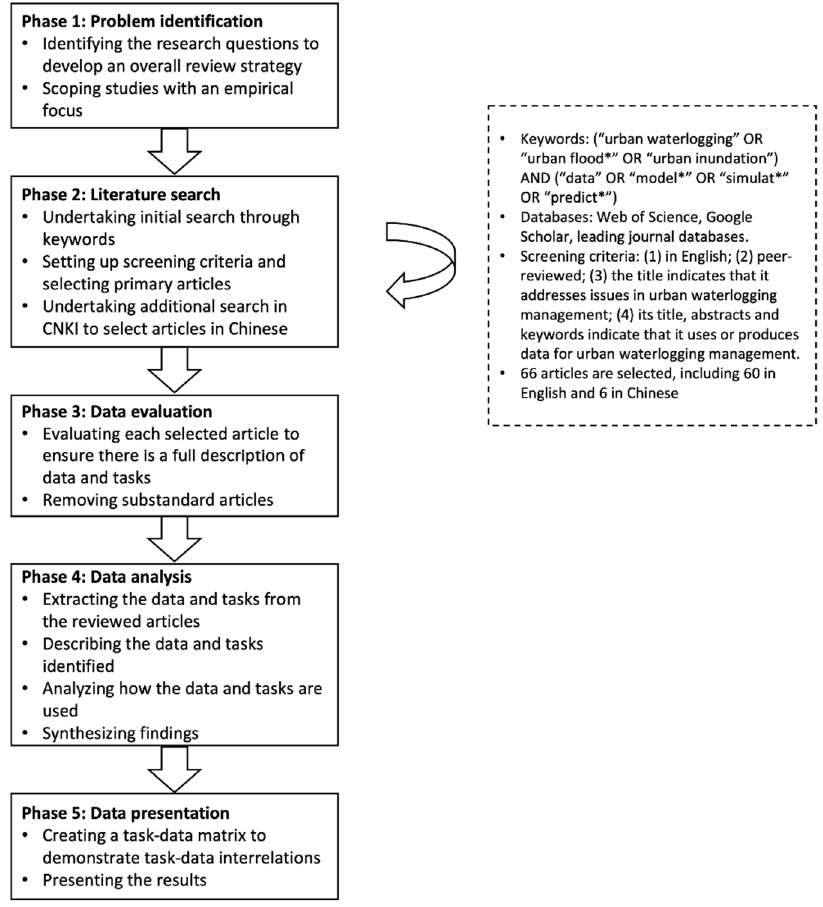
Figure 1. Five phases of the integrative literature review.